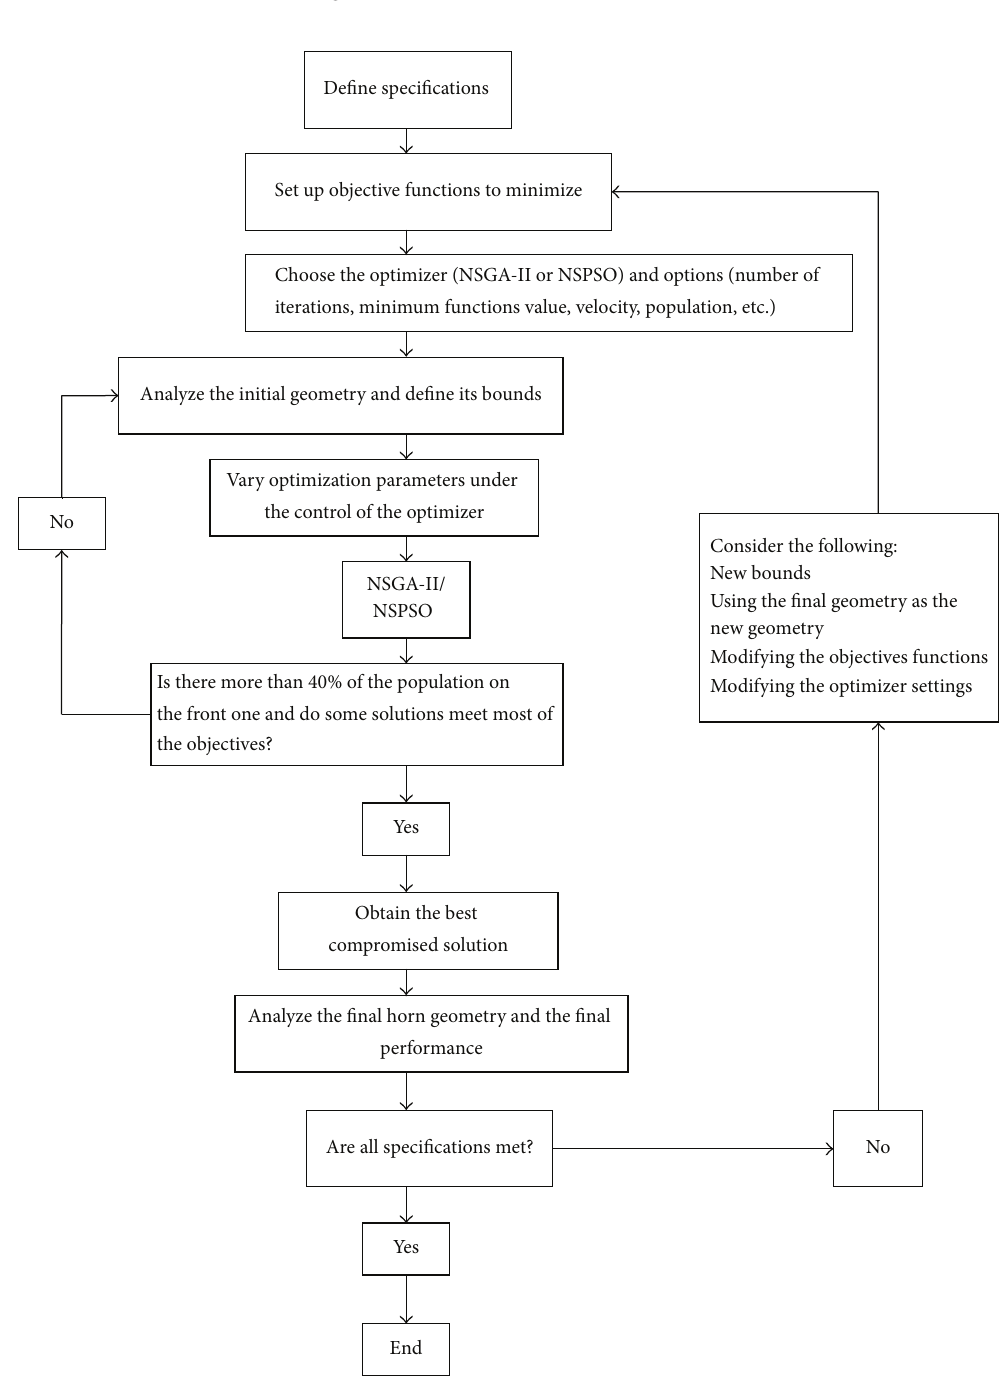
Figure 4: Flow graph of horn